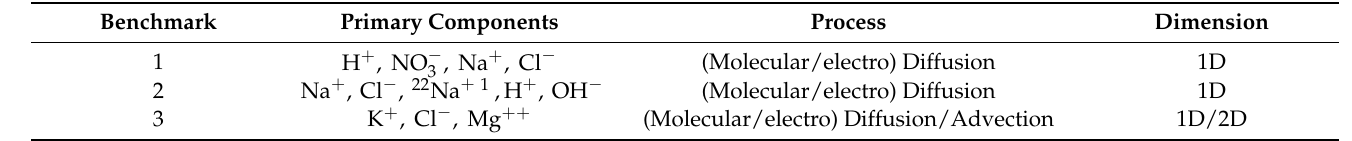
Table 1. Summary of the three multicomponent reactive